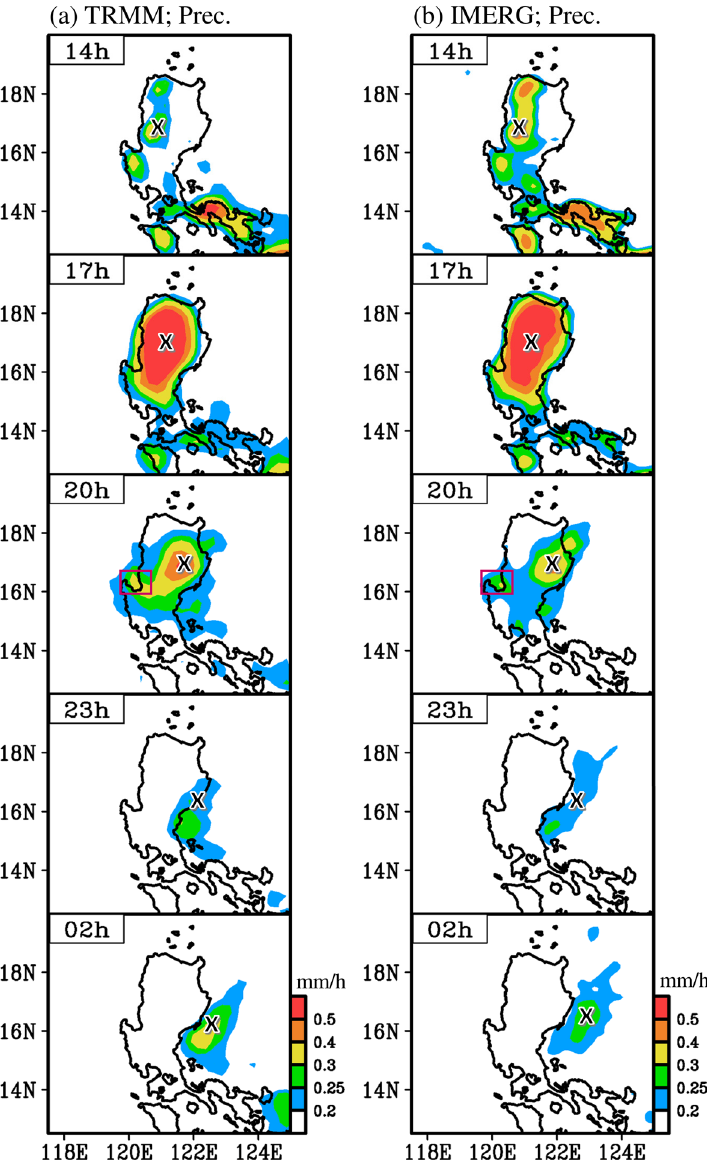
Figure 3. Horizontal distribution of three-hourly precipitation at selected timesteps during a day in spring, averaged during 2001–2019, estimated by: ( a ) TRMM and ( b ) IMERG. The times (14–02 h) represent the local time in the Philippines. The symbol “x” indicates the eastward propagation of diurnal precipitation, while the open square at 20 h is added to clarify the discussion. This figure is created using the software of GrADS